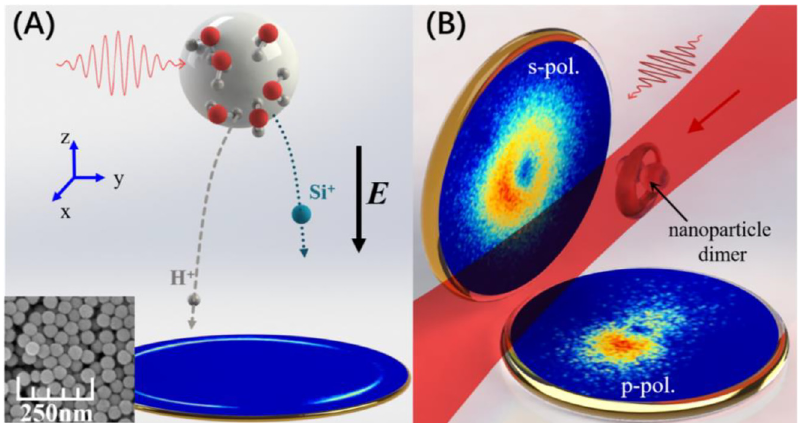
Figure 1: (A) Schematic drawing of the experimental apparatus. The black arrow indicates the static electric field in the velocity map imaging (VMI) spectrometer, andthe bluearrows show the coordination of the experiment. The inserted image on the lower-left corner is the scanning tunneling electron microscopy (SEM) image of the 50 nm SiO 2 nanoparticles. (B) Schematic illustration of the momentum distributions of the protons ejected from the surface molecules under low-intensity excitation projected onto two orthogonal planes. The nanoparticle dimer is oriented along the laser polarization